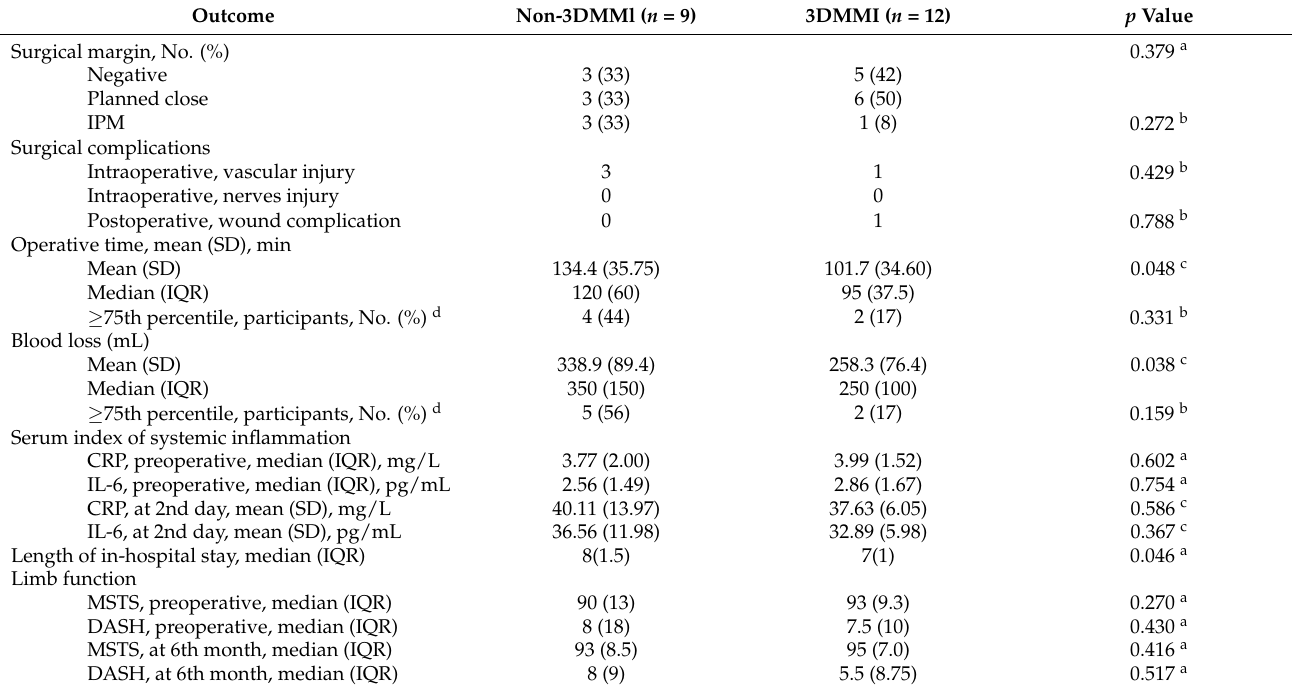
Table 2. Comparative outcomes between groups who underwent limb salvage surgery with and without 3DMMI-based preoperative